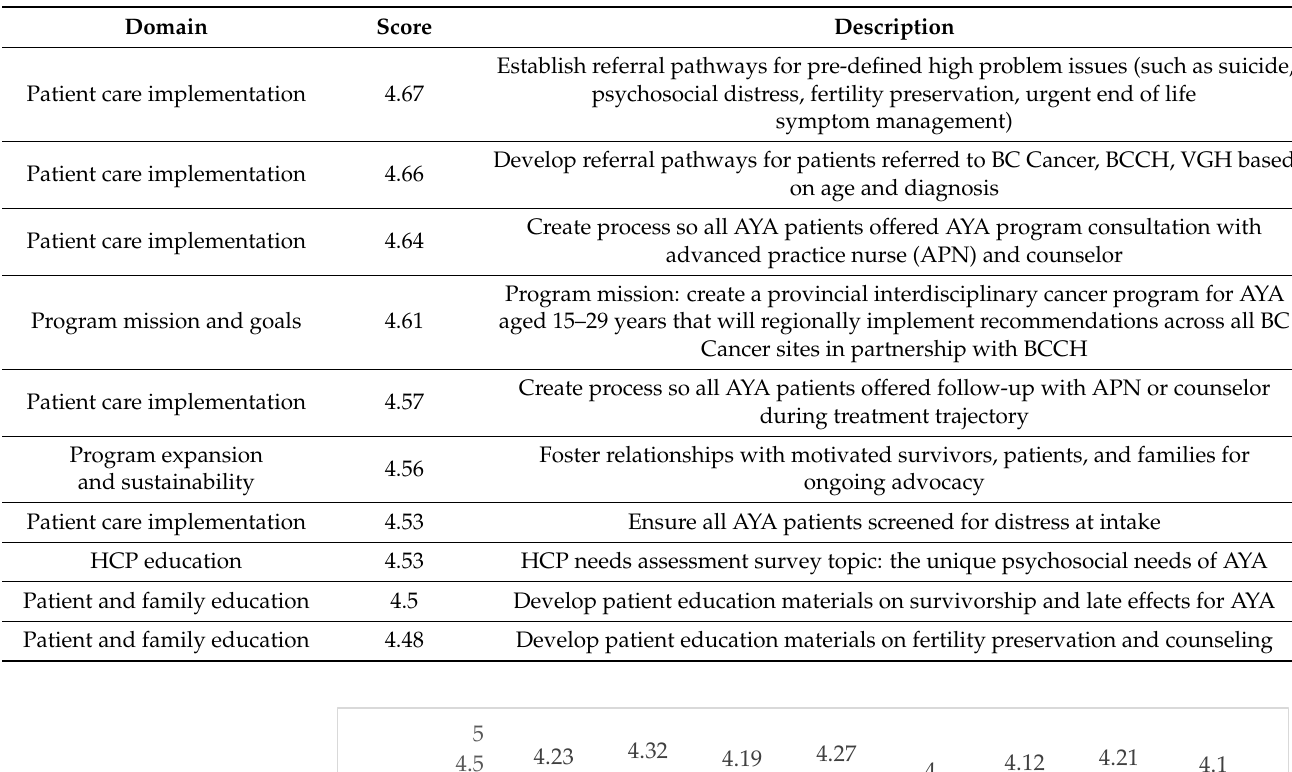
Table 1. Top 10 highest rated items across all components.